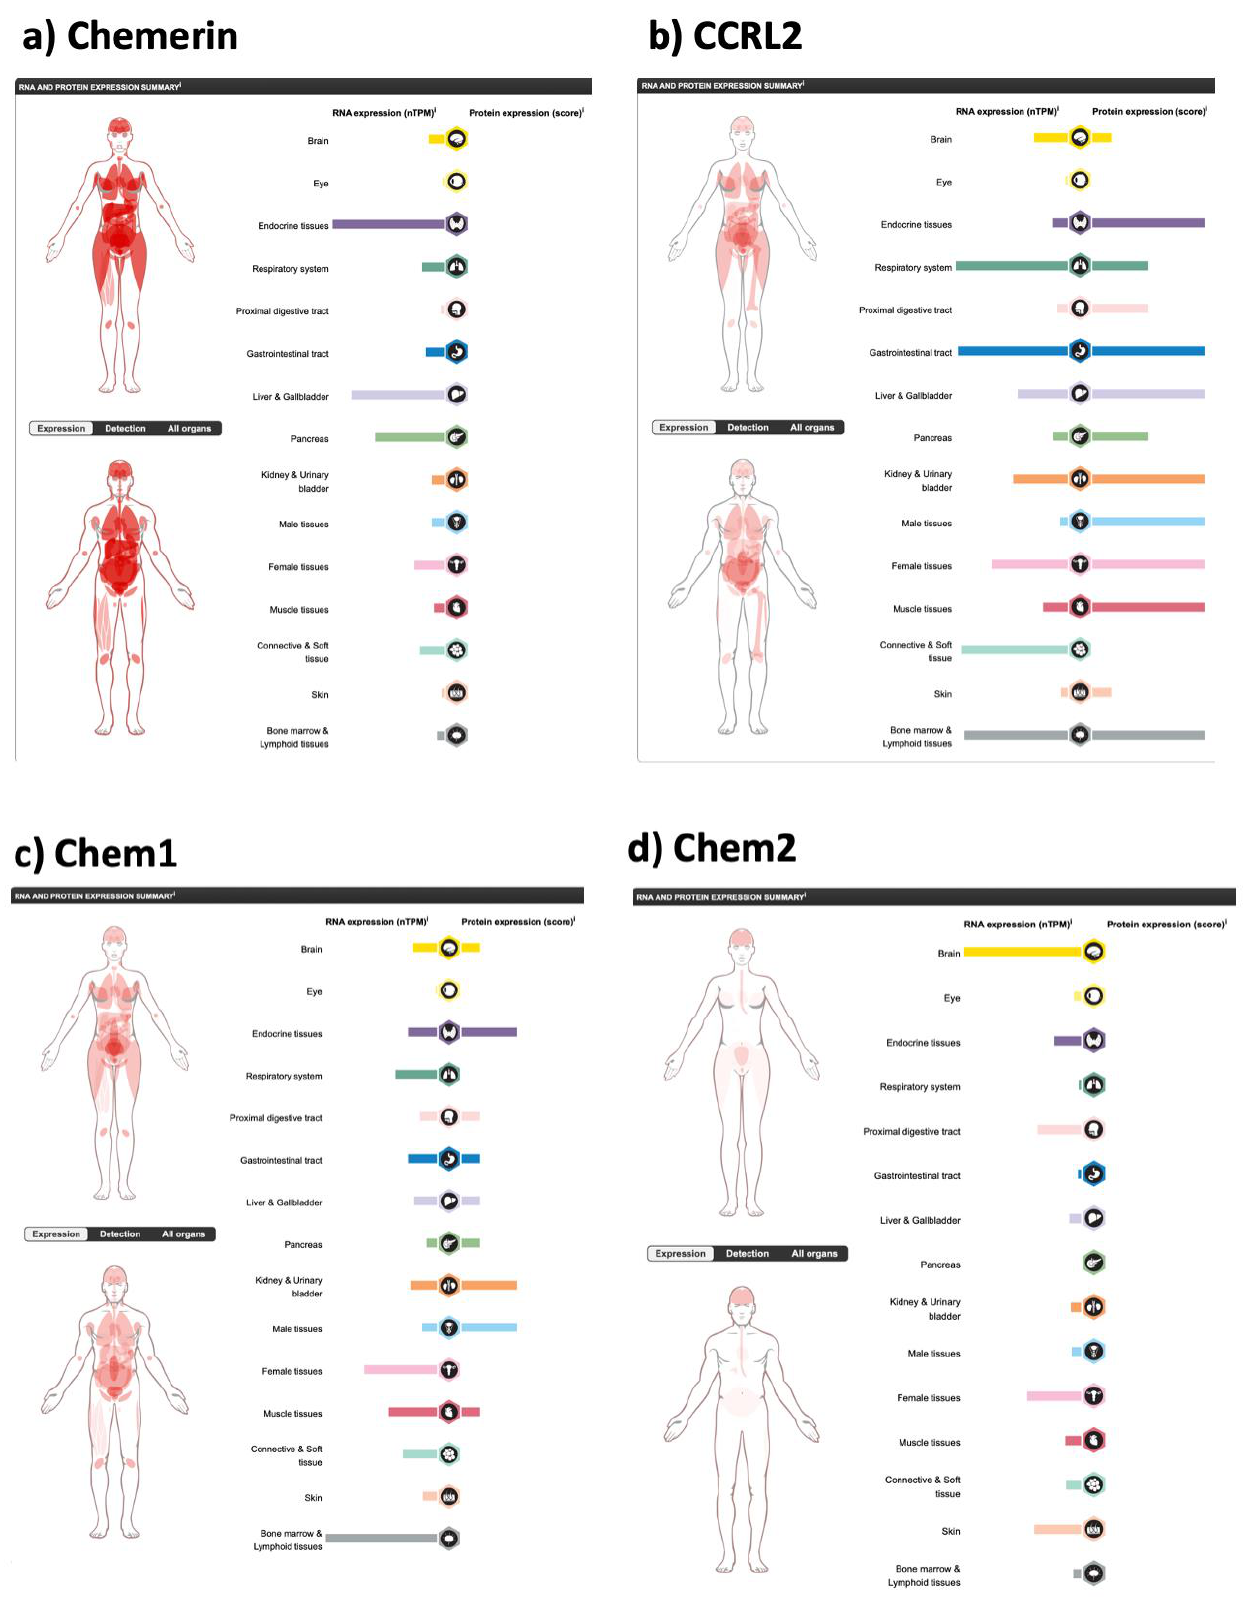
Figure 4. Expression of the components of the chemerin system in different tissues, on the left showing the mRNA expression data for each in normalized transcripts per million (nTPM), and on the right, where available, the score is the protein expression data based on immunohistochemical